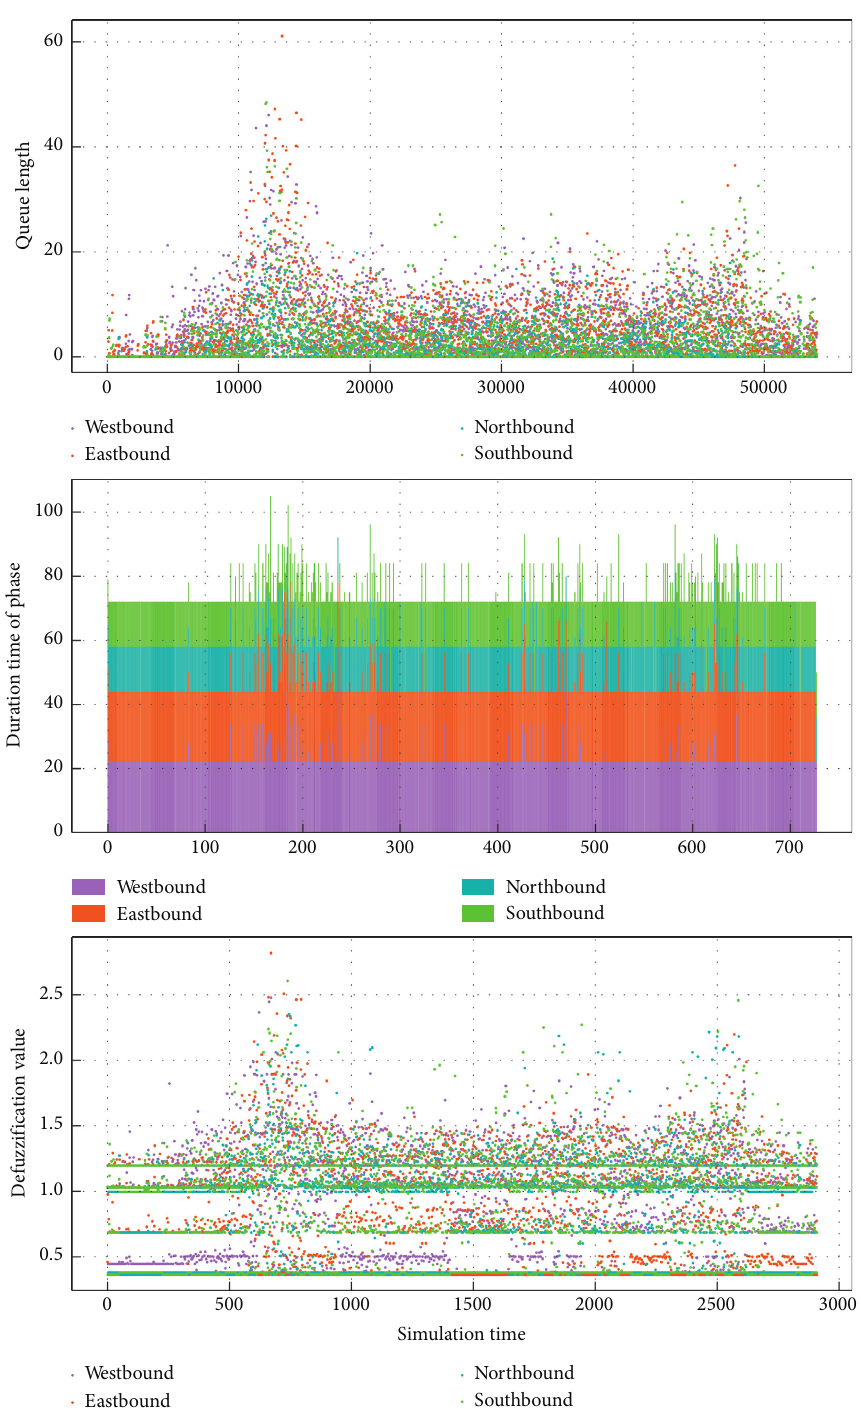
Figure 6: Parameter variation under HGA fuzzy control